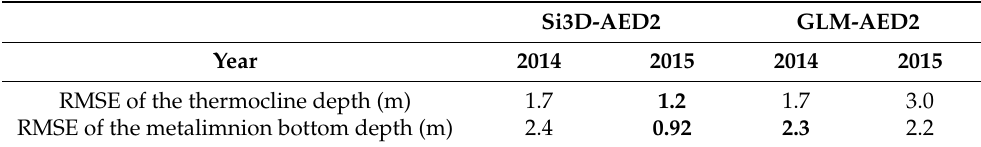
Table 6. The RMSEs of the predicted thermocline depths and the metalimnion bottom depths for the entire stratified period of 2014 and 2015 from Si3D and GLM-AED2 simulations. The relatively lower RMSEs between the 1-D and 3-D model results are shown in bold.